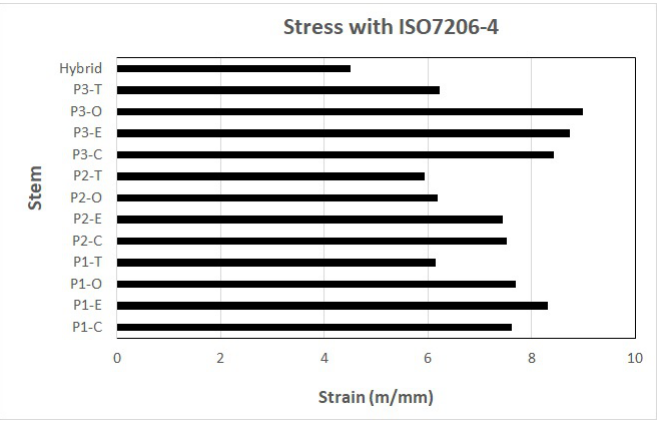
Figure 6. Results of equivalent stress of von Mises with the use of ASTM F2996-13 and ISO 7206–4:2010(E). P1, P2, and P3 represent the profile numbers, and the letter represents the type of cross-section (C = circular, E = ellipse, O = oval, T = trapezoidal).